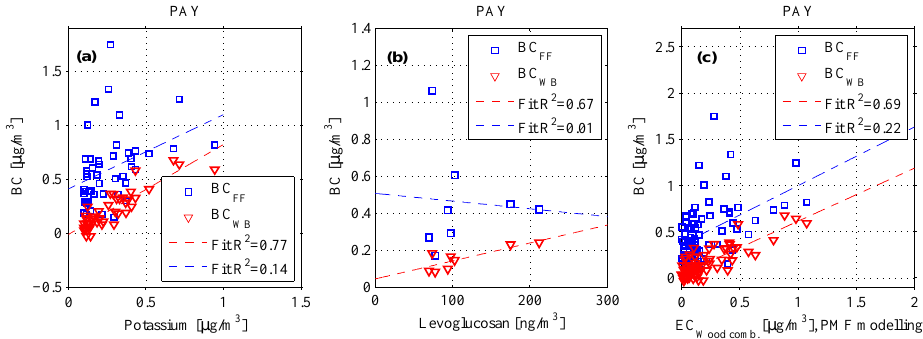
Fig. 5. Scatter plot of daily BC (BC FF and BC WB ) and potassium for PAY (a) . Scatter plot of daily BC (BC FF and BC WB ) and levoglucosan in PM 10 for PAY (b) . Scatter plot of daily BC (BC FF and BC WB ) and EC from wood combustion emissions as derived from PM 10 factor analytical modelling for PAY (c) . All plots include linear regression lines.